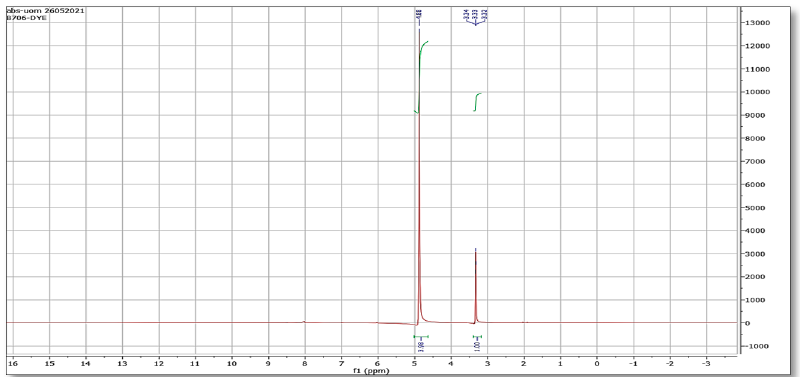
Figure 11. Original Dye Brown 706 1 H NMR.